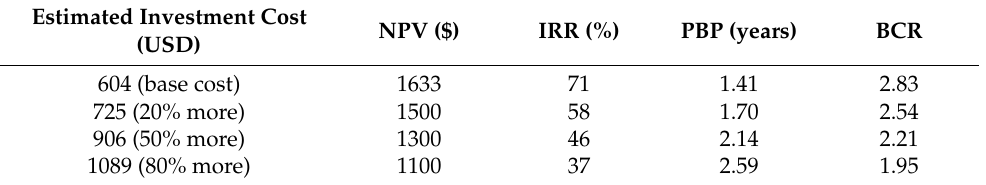
Table 7. Variation of NPV, IRR, PBP, and BCR in relation to increasing dryer